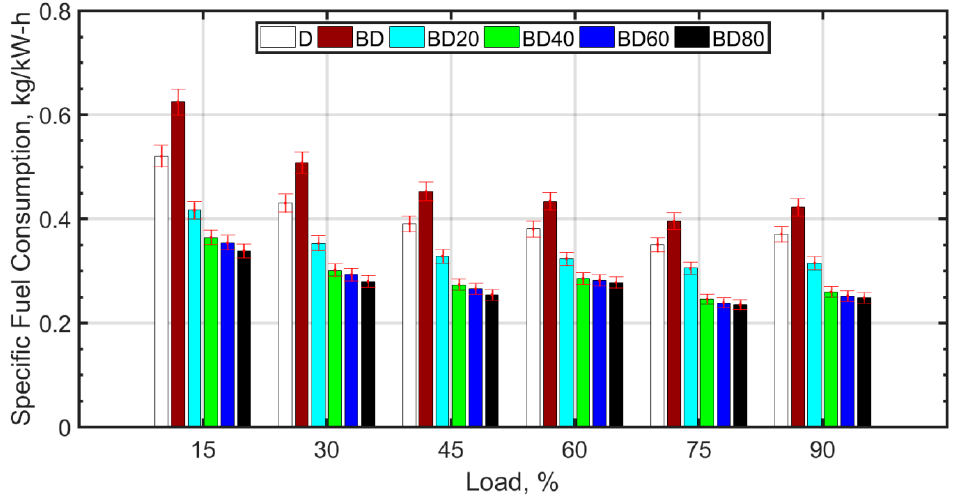
Figure 4. Specific fuel consumption variation with load.